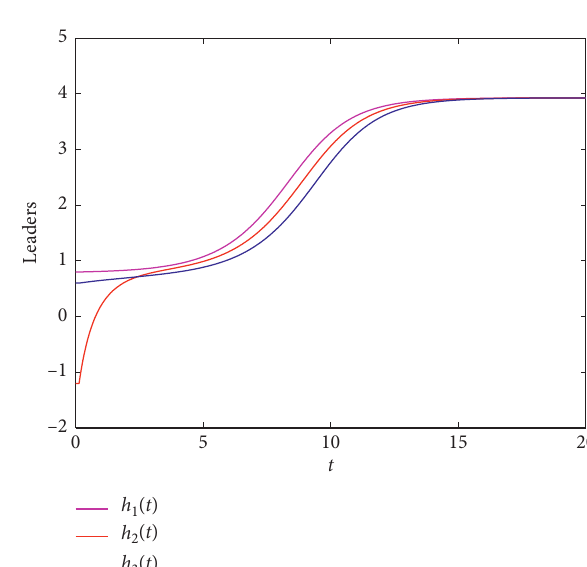
Figure 5: State trajectories of